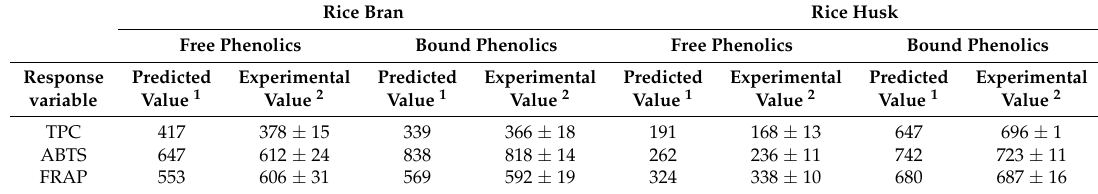
1 Calculated using the predicted equations for response variables at optimal condition, 2 Means of three replicates ± standard deviation; TPC: total phenolic content (mg GAE/100 g); ABTS: ABTS radical scavenging